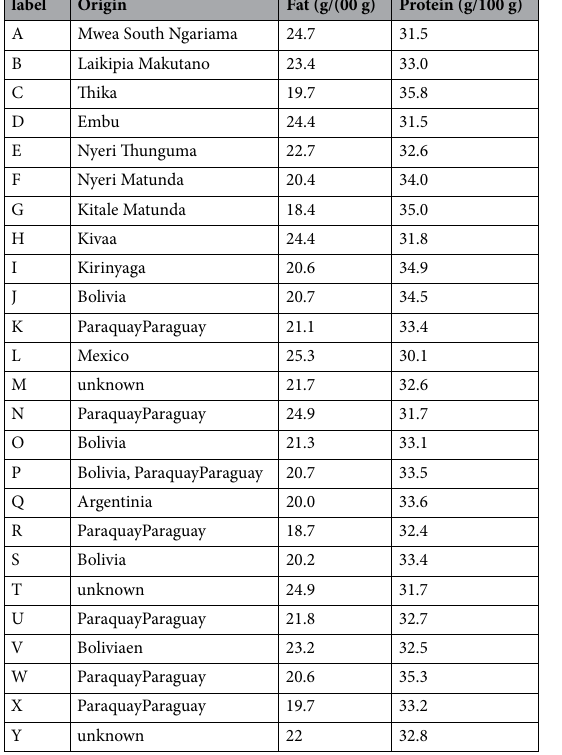
Table 1. Information about growing region and determined values for fat and protein of African (A-I) and purchased (J-Z) chia seeds. Single determinations performed by the Analytical Chemistry module of the Core Facility